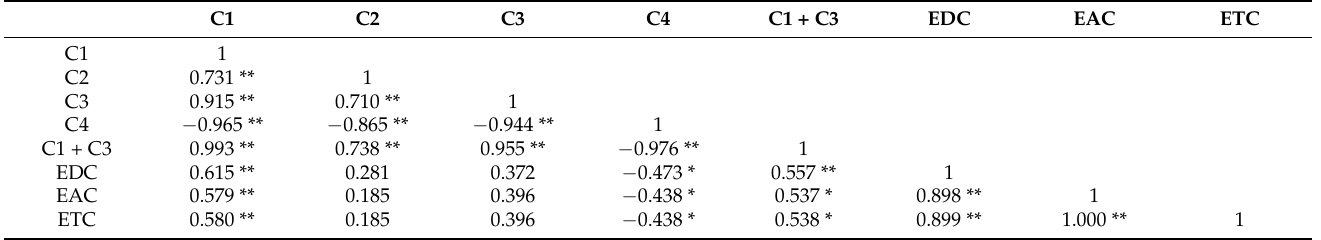
Table 4. Correlation analysis between DOM relative content and ETC.